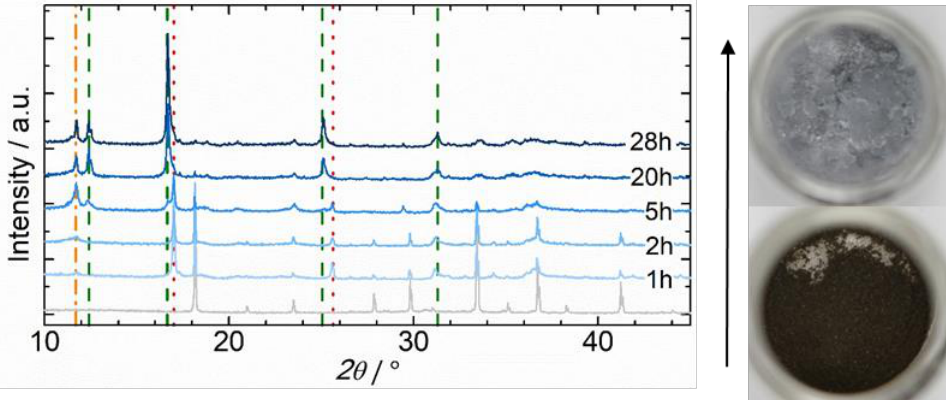
Figure 7. ( Left ): PXRDs for the reactivity test series of sample (a) C12A7 in H 2 O under ambient conditions for different reaction times after drying at 80 °C for 30 min. The diffraction pattern before hydrothermal treatment (grey) shows only reflections of C12A7; Al 2 Ca 4 (OH) 12 CO 3 · 5H 2 O (orange dashed–dotted), unidentified phase (green dashed), and unidentified phase (red dotted lines) are present until a reaction time of 5 h. ( Right ): Photographs of the resulting samples from the reactivity test experiment for (d) C12A7e − (3C) under H 2 O at room temperature. Initial C12A7e − powder (bottom) and reacted powder (top) after 16 h under H 2 O.